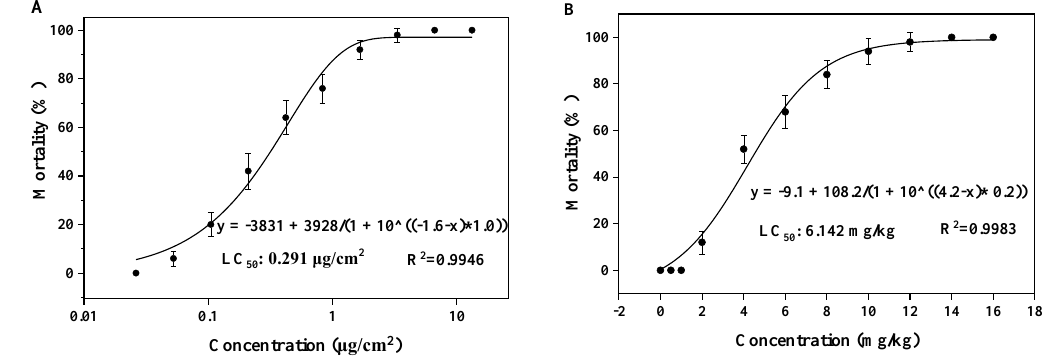
Figure 1. Dose-effect curves of the contact filter paper test ( A ) and the acute artificial soil test ( B ) after exposure to sulfoxaflor.